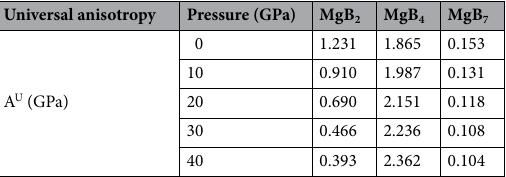
Table 3. Universal anisotropy A U of Mg–B binary compounds at external